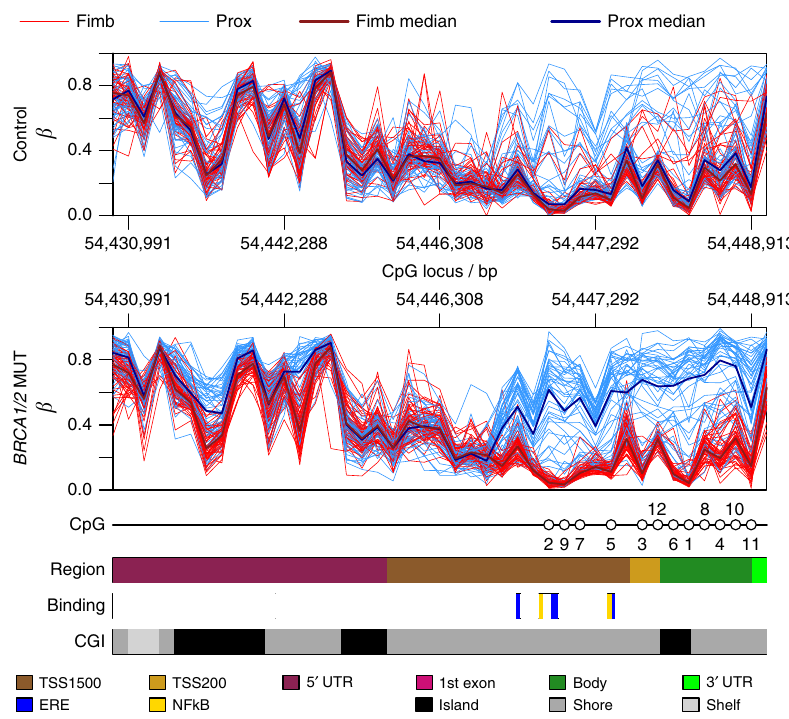
Figure 3 | Methylation profile across HOXC4 for control and BRCA1 / 2 mutant samples. Control ( n ¼ 49), BRCA1/2 ( n ¼ 52). CpGs numbered in Fig. 1a are again indicated here. Genomic regions are shown, together with CpG island information and NFkB- and ERE- (estrogen response element) binding